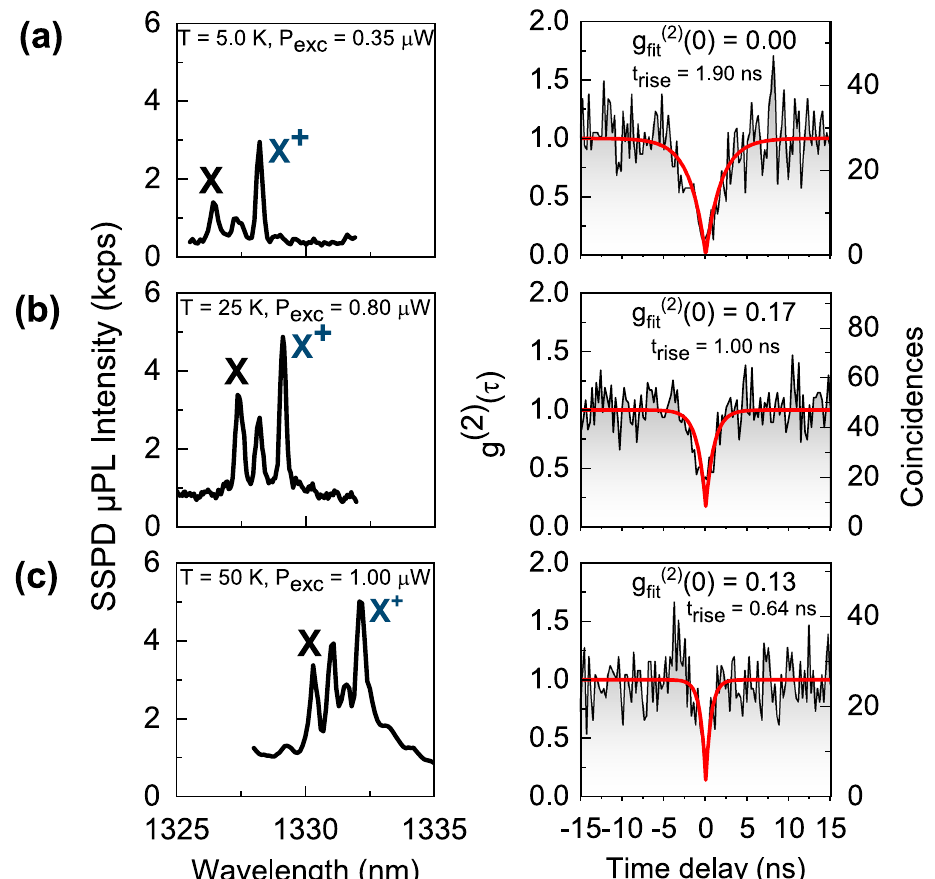
superconducting nanowire single-photon detectors—SNSPDs (left panel) and corresponding autocorrelation histograms (right panel), measured under continuous wave non-resonant excitation at ( a ) T = 5 K, ( b ) T = 25 K, and ( c ) T = 50